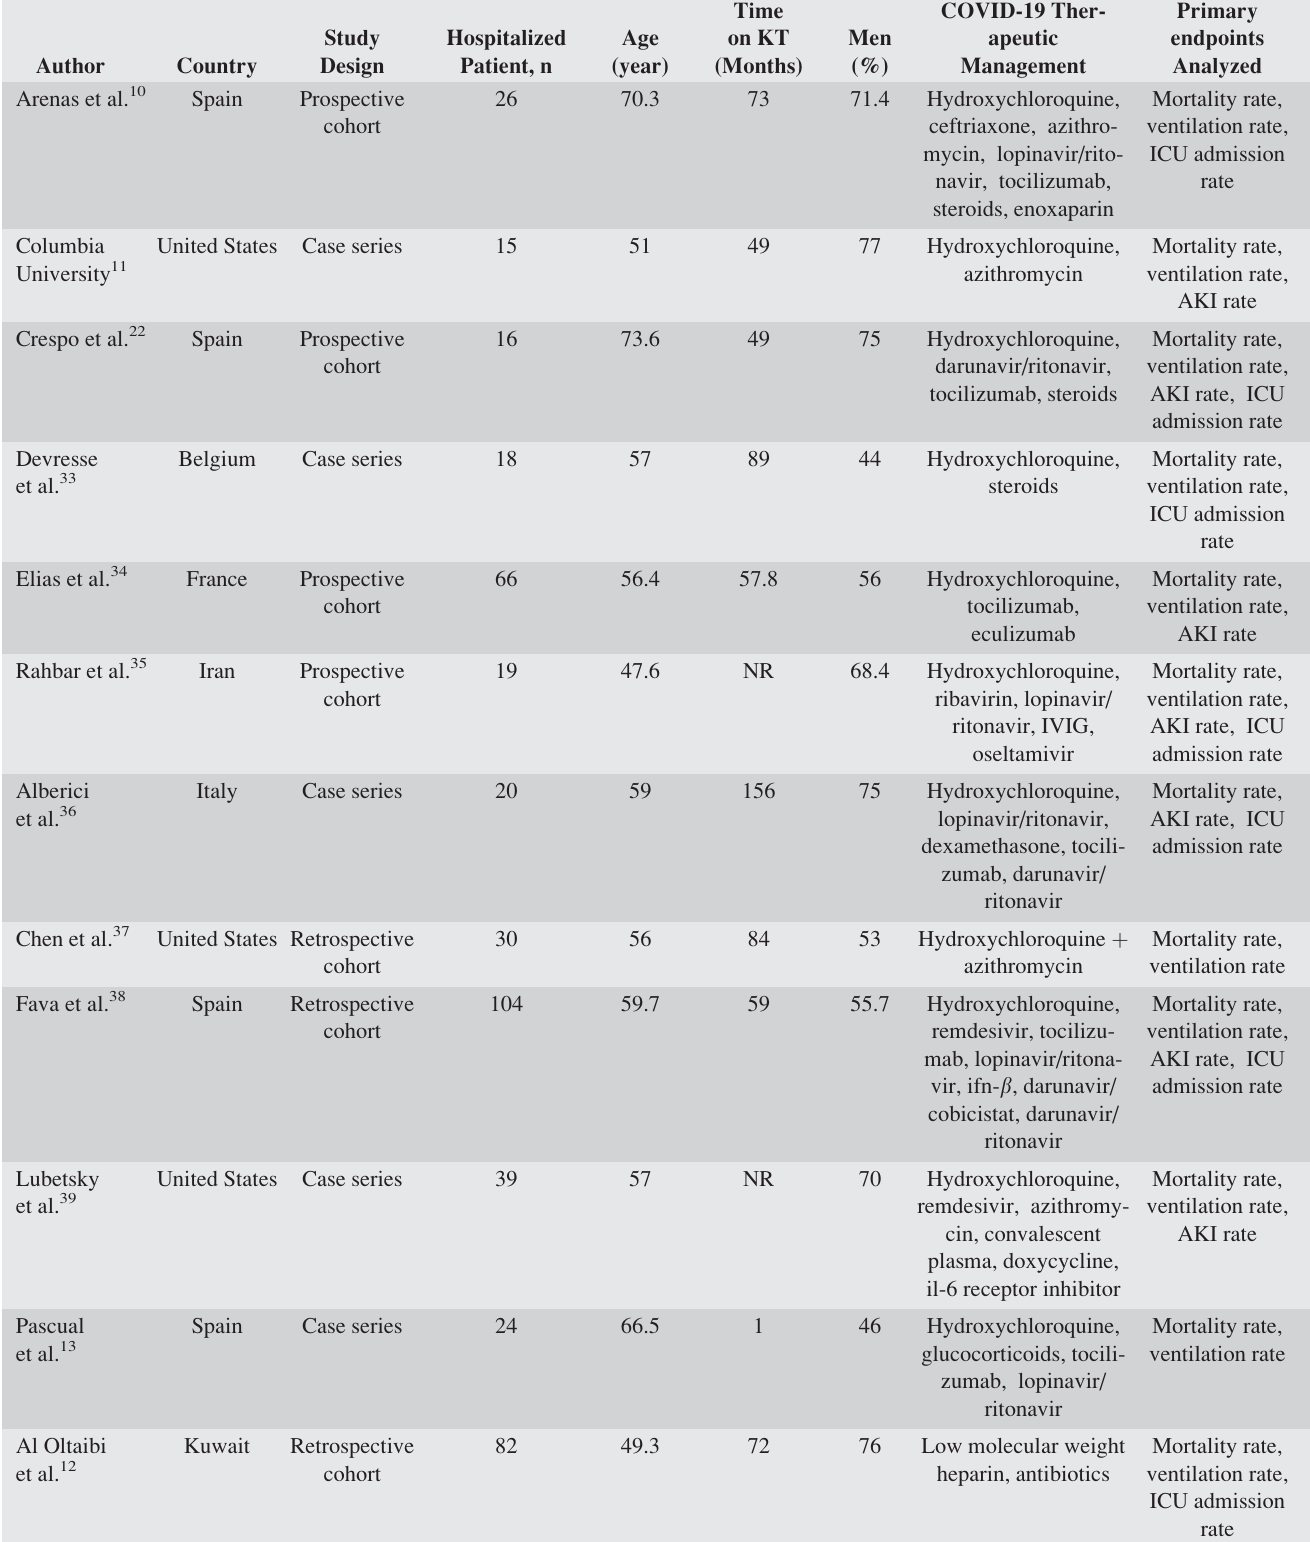
Table 2. Baseline Characteristic of the Included